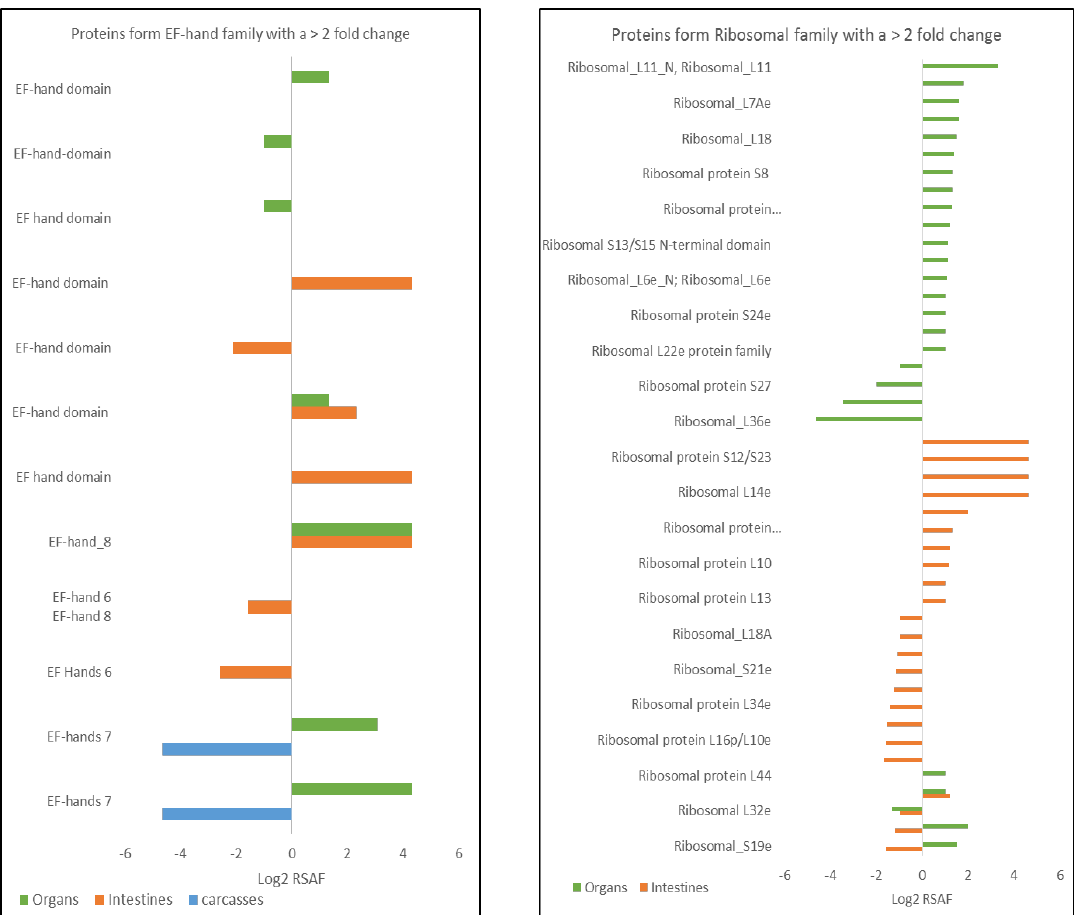
Figure 3. Histograms showing some proteins families with differential expression levels with ≥ 2-fold change. For graphic purposes proteins that were detected only in one set of samples were assigned a relative spectral abundance factor (RSAF) of 25, and as result of log2 transformation is equal to 4.64. Proteins that were identified only in the control sample are presented as − 4.64 ( – log 2 25.).